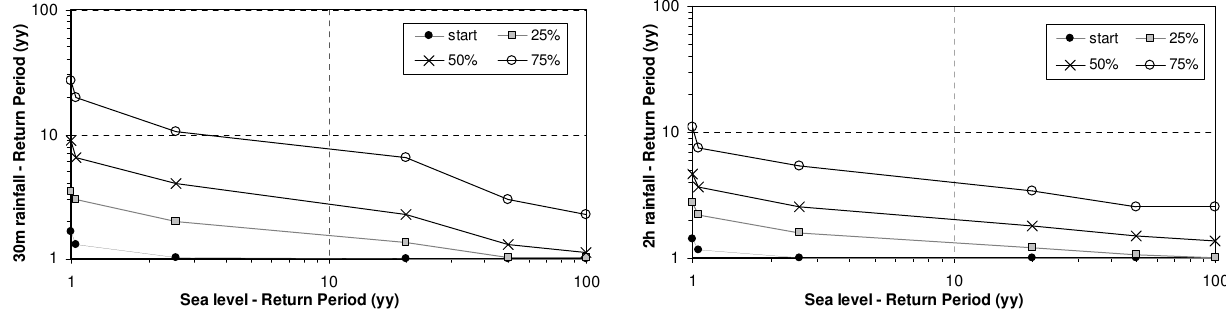
Fig. 9. Isolines representative of an equal percentage of flooded nodes presented as a function of rainfall intensity and sea level return periods. “Start” condition represents the threshold condition right before flooding